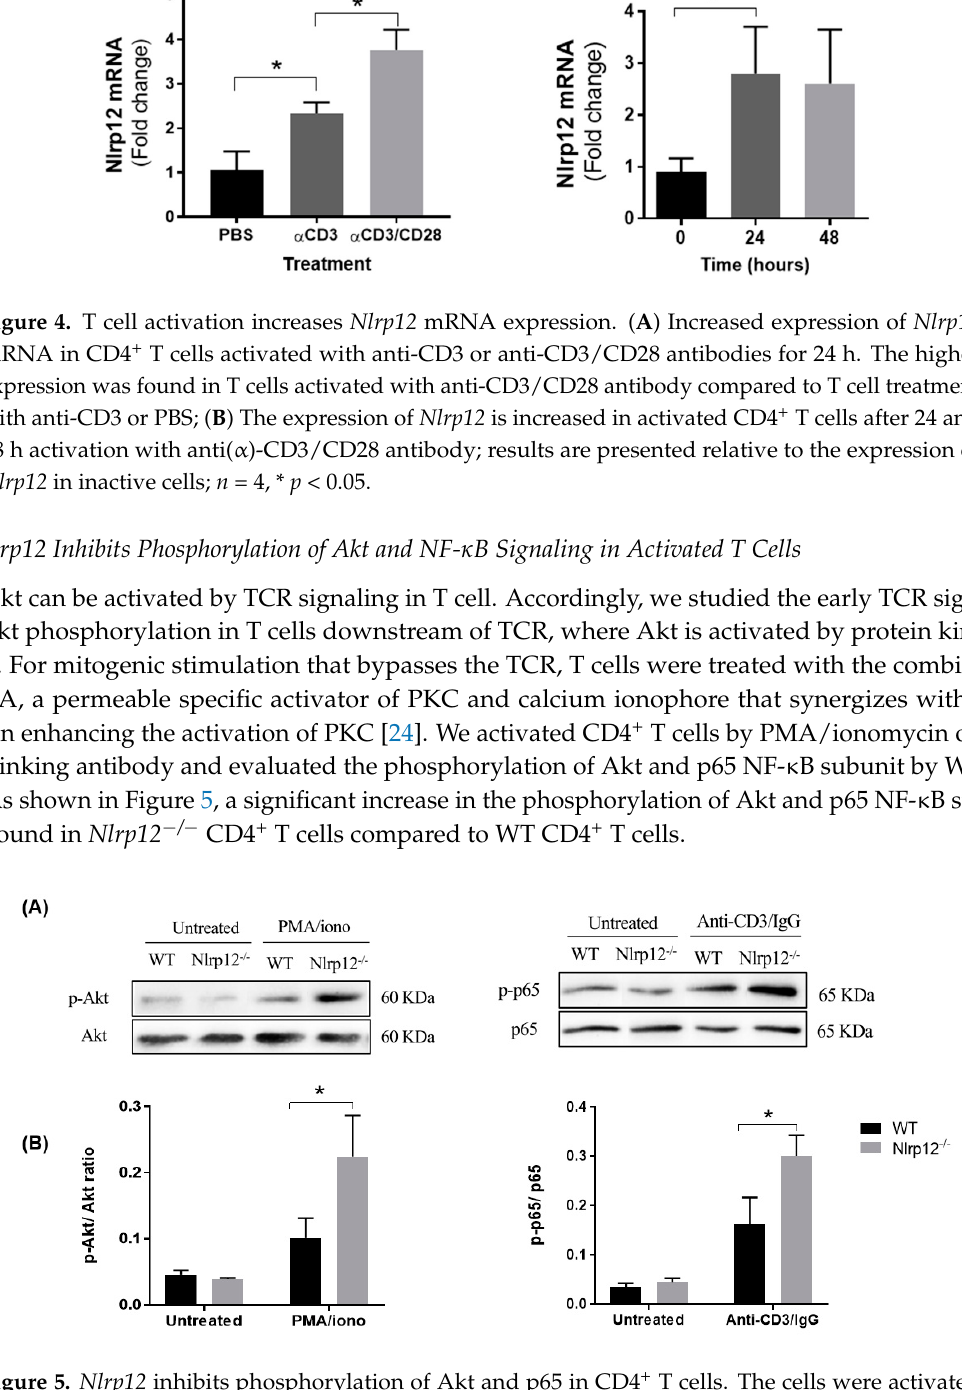
Figure 5. Nlrp12 inhibits phosphorylation of Akt and p65 in CD4 + T cells. The cells were activated either with PMA/ionomycin for 10 min or with cross-linking anti-CD3 antibody (anti-CD3/IgG) for 20 min at 37 ◦ C. ( A ) Samples were analyzed by SDS-PAGE and immunoblotting for phospho-Akt (S473) and phospho-p65. Total Akt and p65 expression in the same lysates were used to normalize the expression of phosphorylated molecule between samples; ( B ) The ratio of phosphorylated to total molecules were compared between WT and Nlrp12 − / − cells, n = 3, * p <